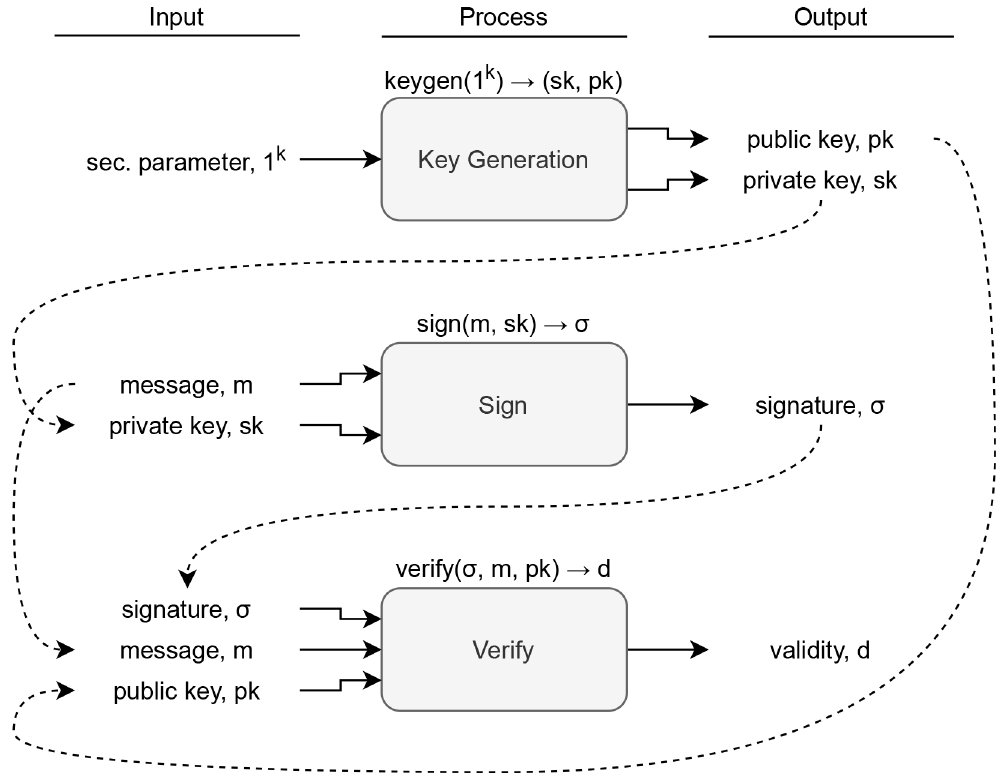
Figure 1. The three processes of a digital signature scheme and the relationship between the